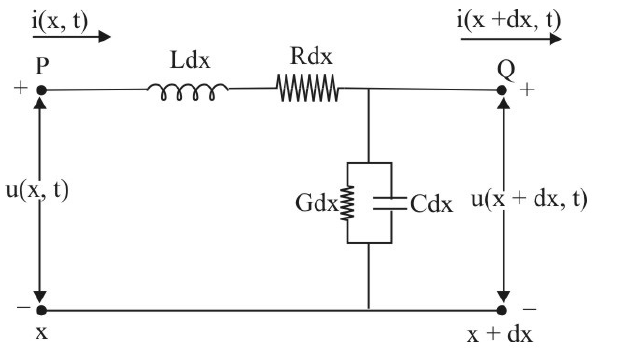
Figure 1. Schematic diagram of a telegraphic transmission line with